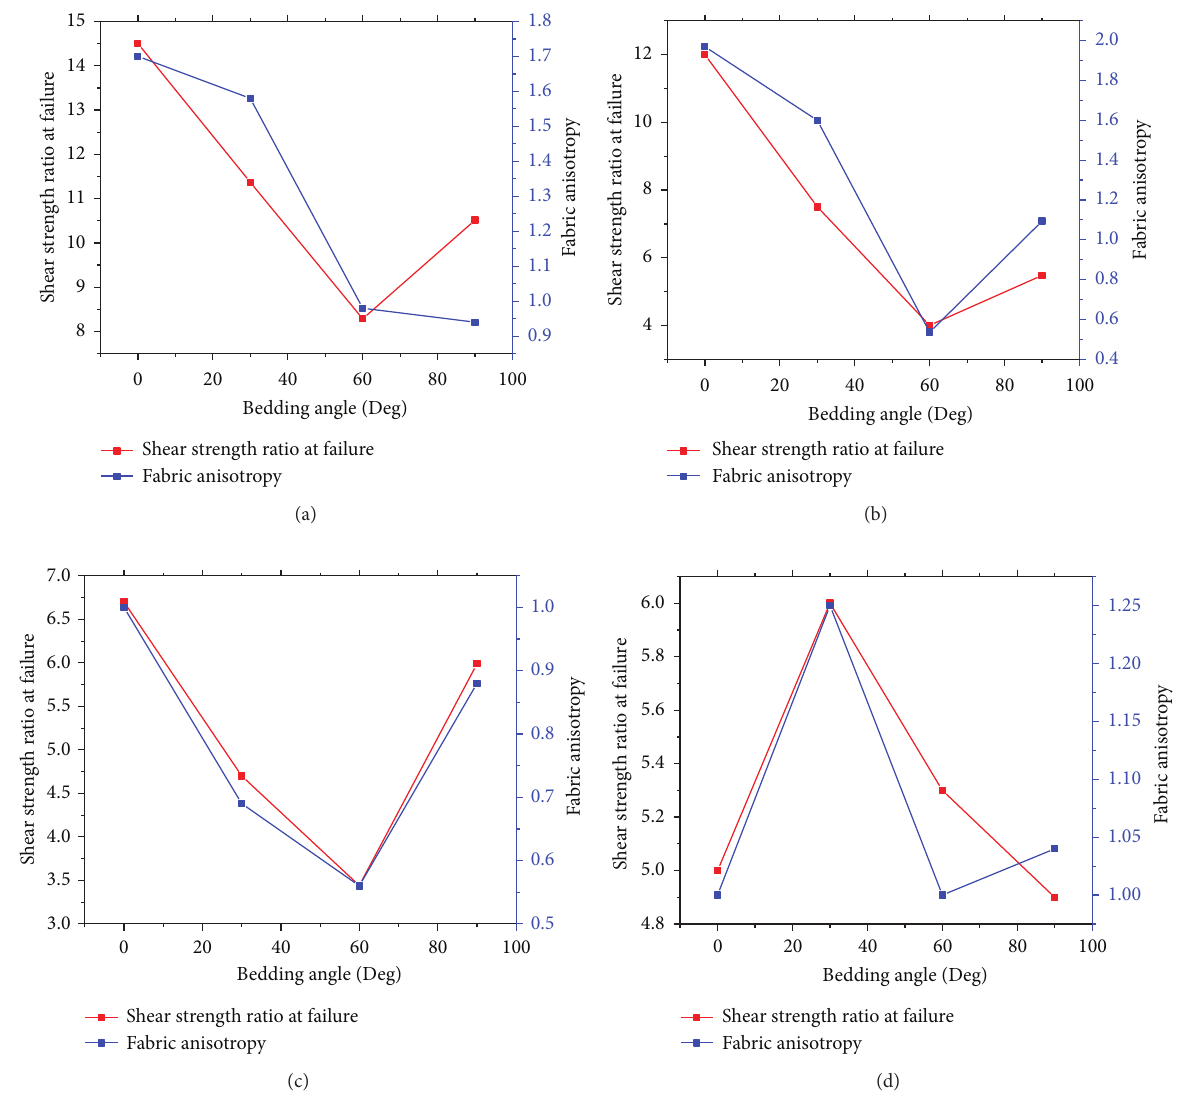
Figure 1: Samples with 𝜙 𝜇 = 52 ∘ and 𝑟 1 /𝑟 2 = 1.1 (a), 𝜙 𝜇 = 26 ∘ and 𝑟 1 /𝑟 2 = 1.1 (b), 𝜙 𝜇 = 52 ∘ and 𝑟 1 /𝑟 2 = 1.4 (c), and 𝜙 𝜇 = 26 ∘ and 𝑟 1 /𝑟 2 = 1.4